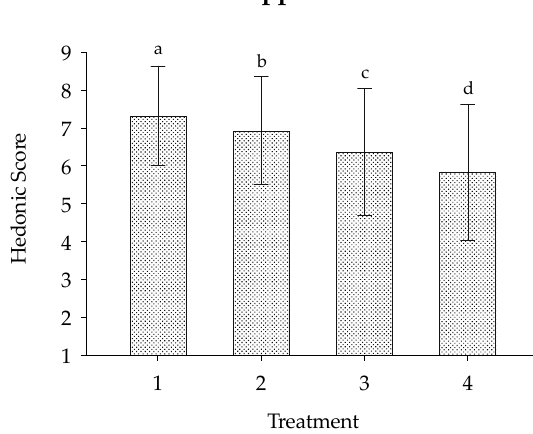
Figure 1. Panellists ( n = 111) rated the appearance of four probiotic yogurt treatments using a nine-point hedonic scale ranging from 1 (dislike extremely) to 9 (like extremely). A one-way repeated-measures ANOVA and Fisher’s least significant di ff erence test were used to analyse statistically significant di ff erences ( p < 0.05) between mean hedonic scores. Significant di ff erences between treatments are denoted by di ff erent lowercase letters (a–d) above each bar graph. (Treatment 1 indicates 100% cow milk (control); Treatment 2, 75% cow milk + 25% soymilk; Treatment 3, 50% cow milk + 50% soymilk; Treatment 4, 25% cow milk + 75% soymilk).